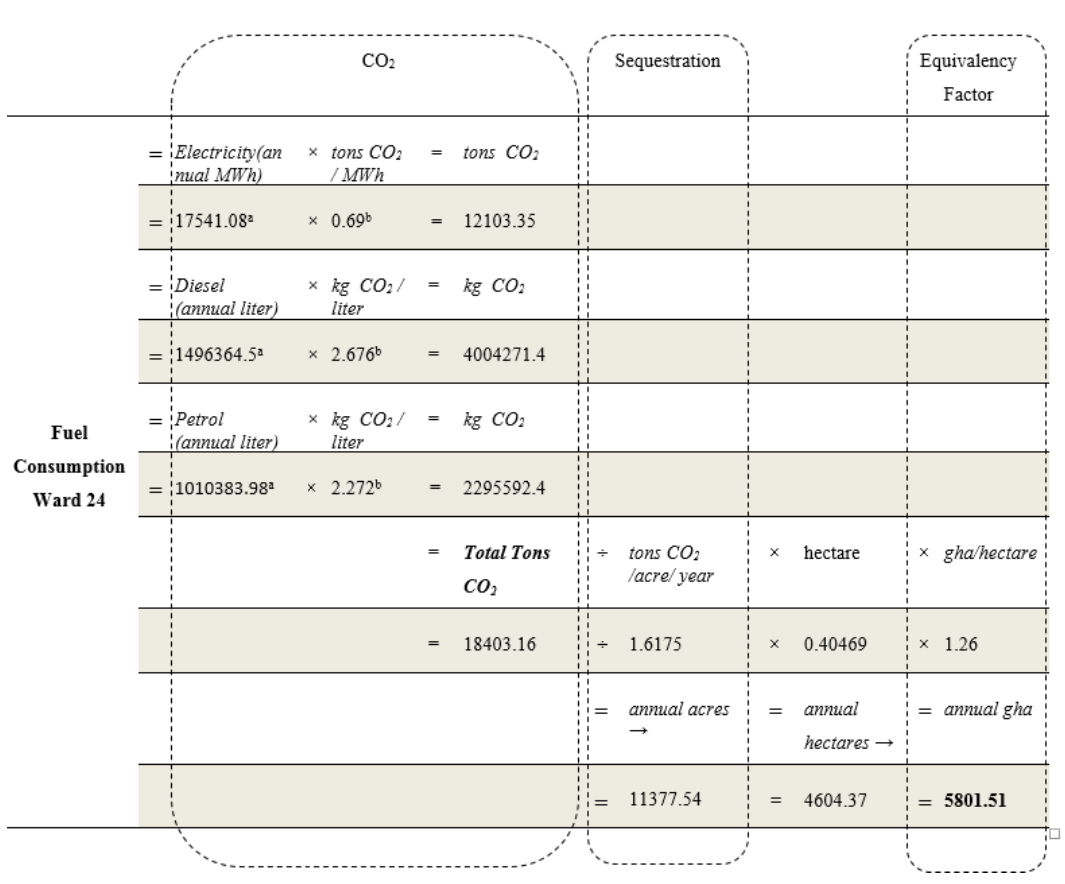
Figure 8. Fuel consumption footprint calculation and derivation. Source: a Household Survey of Ward 24 Residential Area (RA) (2015); [59]; b [60].